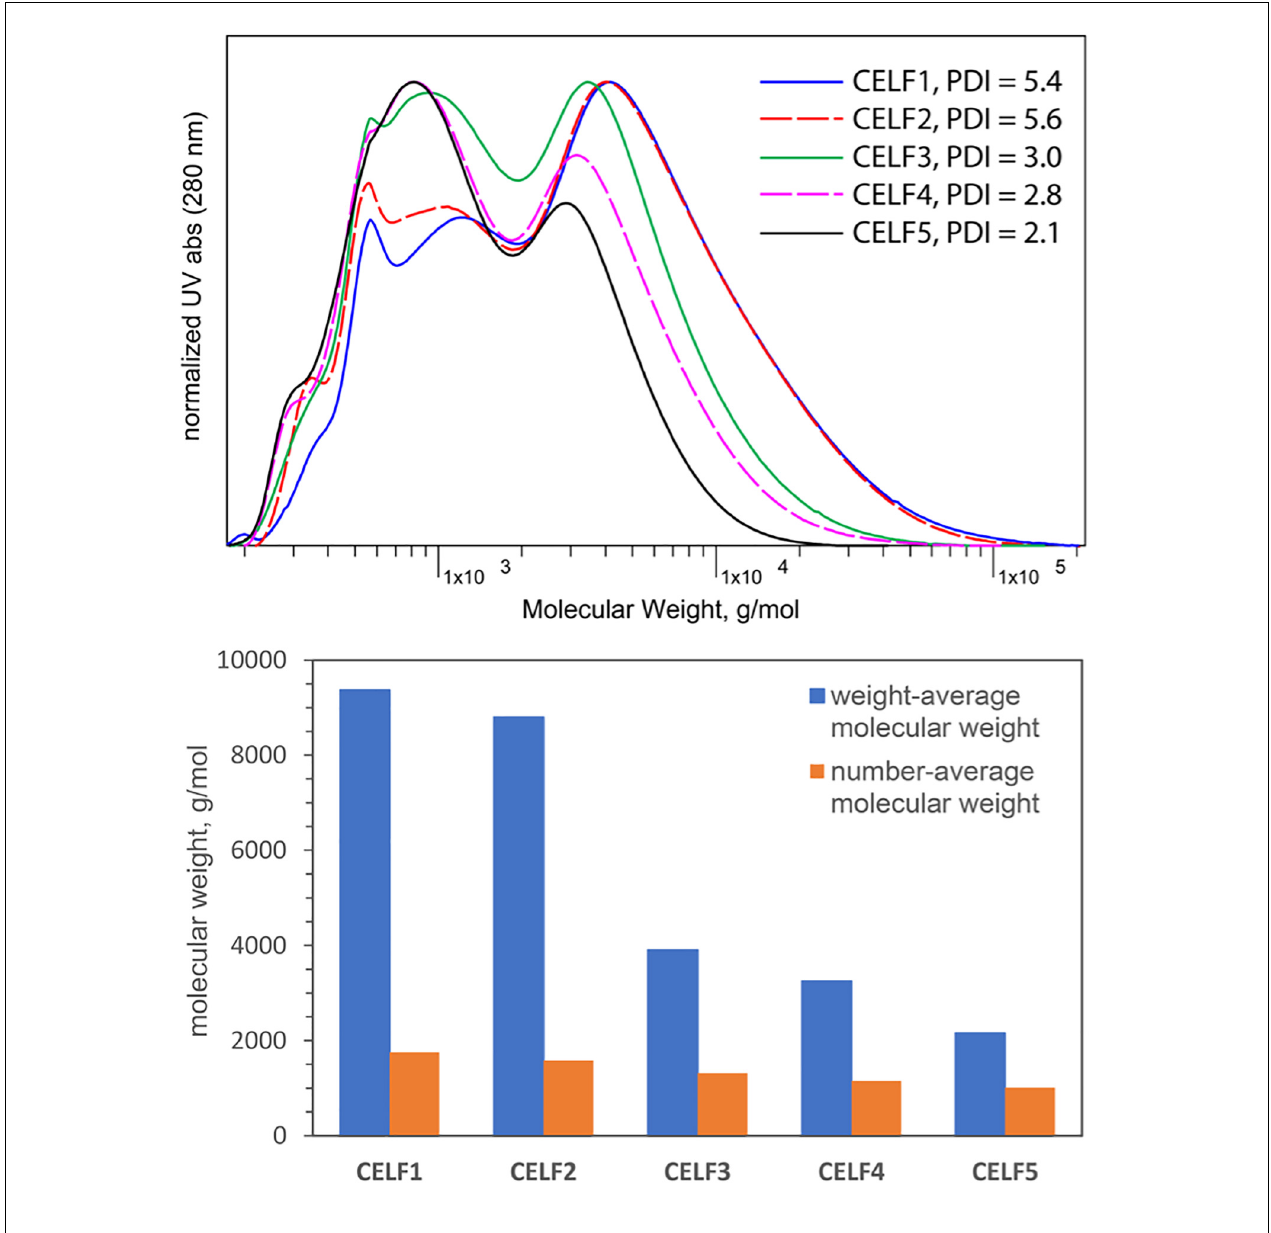
FIGURE 1 | GPC profiles, weight-average and number average molecular weights of CELF lignin obtained under different pretreatment conditions.